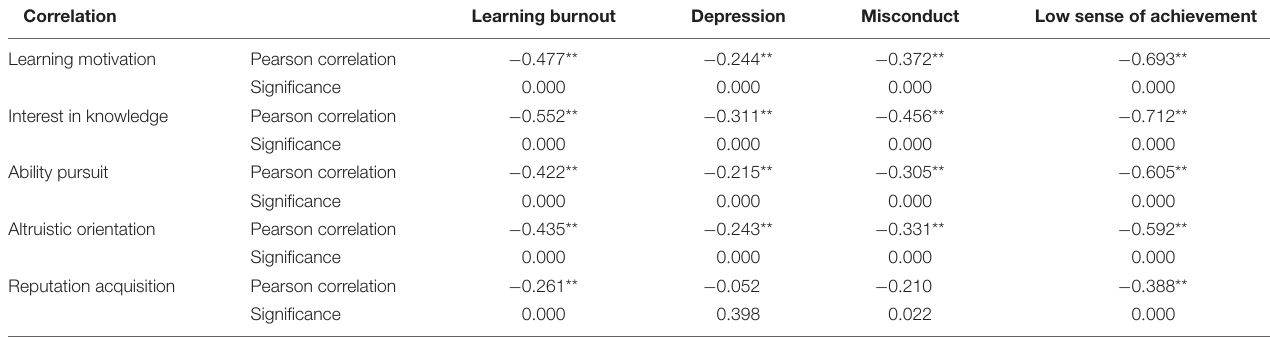
TABLE 2 | Correlation analysis between various dimensions of learning motivation and learning burnout. Correlation Learning burnout Learning